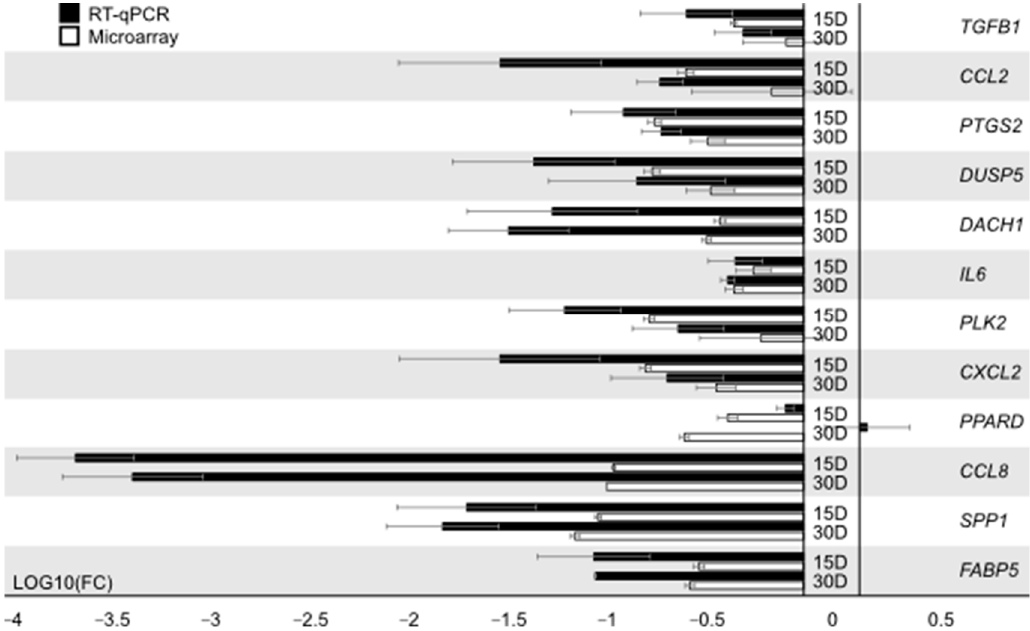
Figure 9. The results of RT-qPCR validation of the analyzed genes, presented in a form of bar graph.